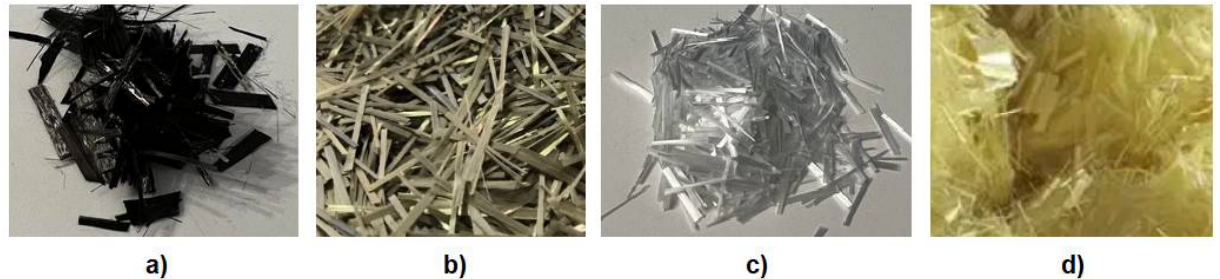
Figure 3. Main type of fibres: ( a ) carbon fibres; ( b ) basalt fibres; ( c ) glass fibres; and ( d ) aramid fi- bres .